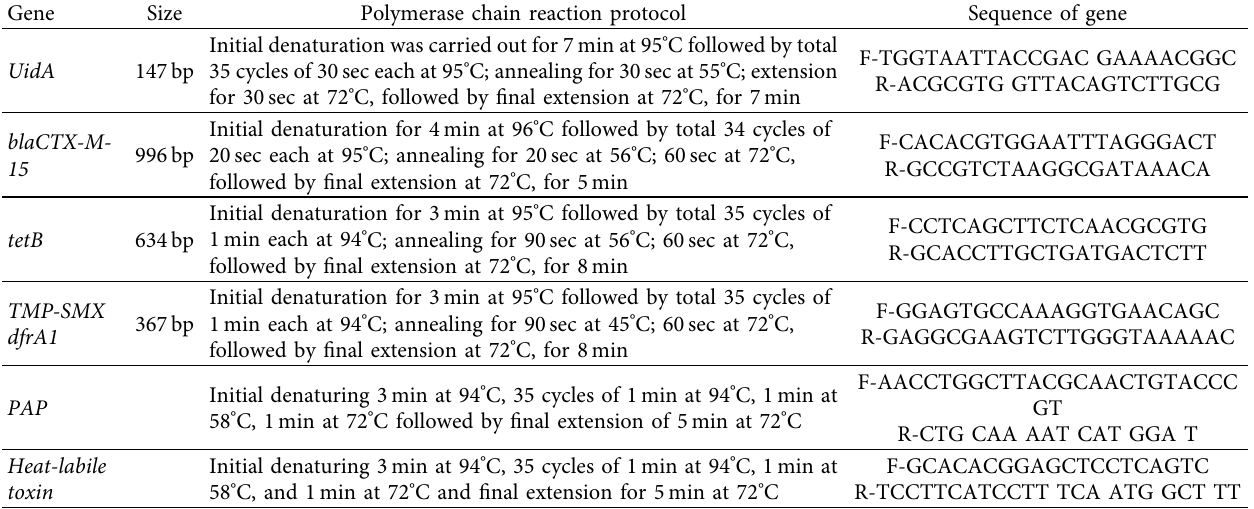
Table 1: Details of primers and their respective polymerase chain reaction